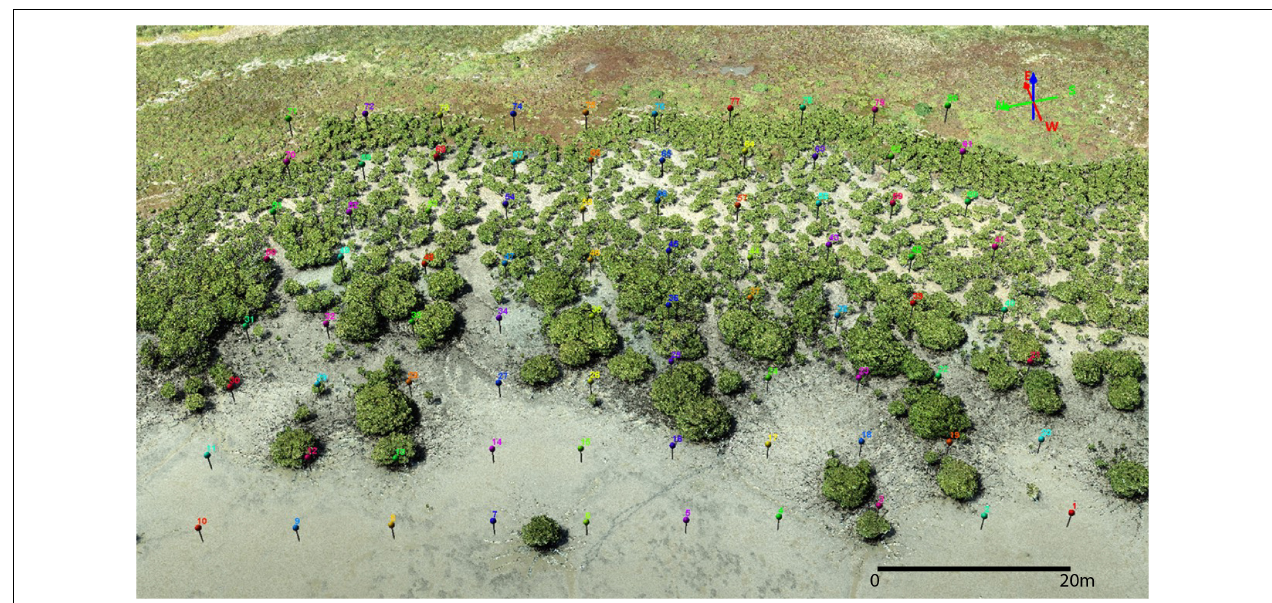
FIGURE 2 | Configuration of stainless-steel rods at Pioneer Bay, Western Port Bay. Site coordinates are 38 ◦ 22 (cid:48) 11.5 (cid:48)(cid:48) S 145 ◦ 32 (cid:48) 52.2 (cid:48)(cid:48)